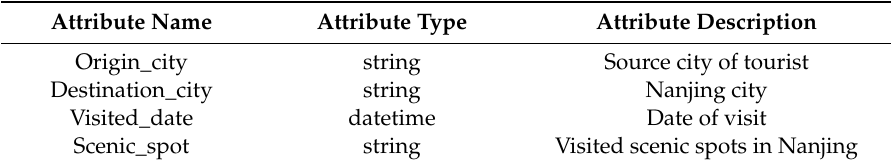
Table 2. Data structure of tourist flow